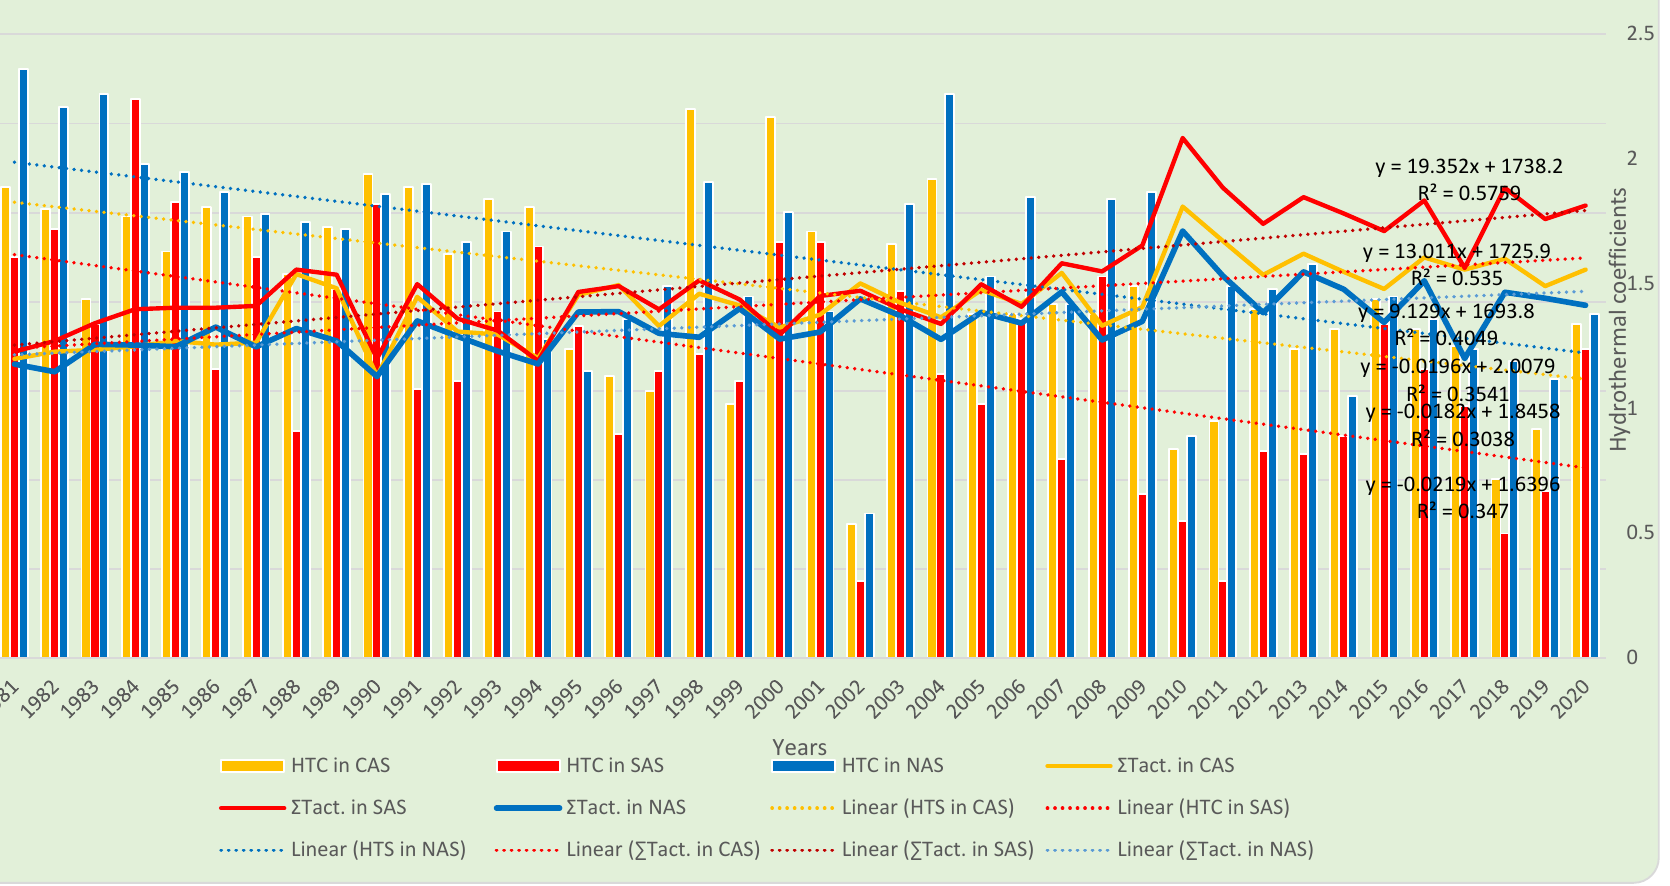
Figure 2. Dynamics of the sum of active temperatures and HTC in the agro-climatic subzones of the Central region of Russian Non-Chernozem zone over a 40-year period